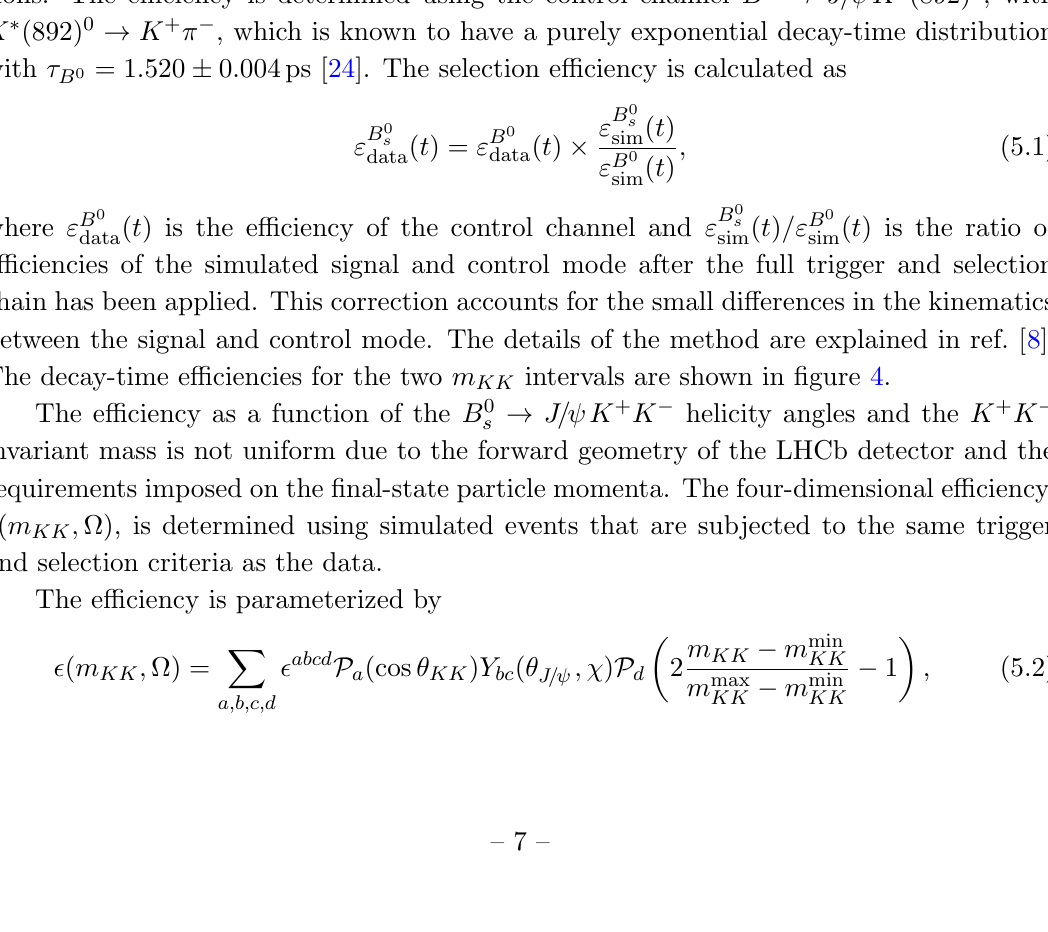
Figure 3 . Invariant mass squared of K + K (cid:0) versus J= K + for B 0 15 MeV of the B 0 mass peak. The high intensity (cid:30) (1020) resonance band is shown with a line s (cid:6) (light